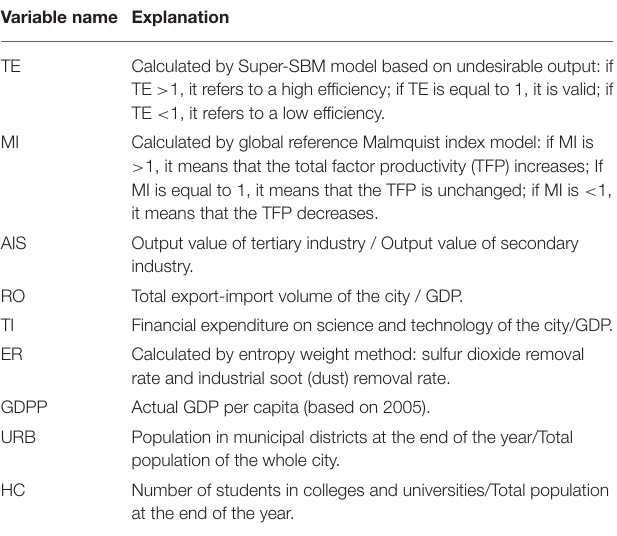
TABLE 1 | Variable of panel regression model. Variable name